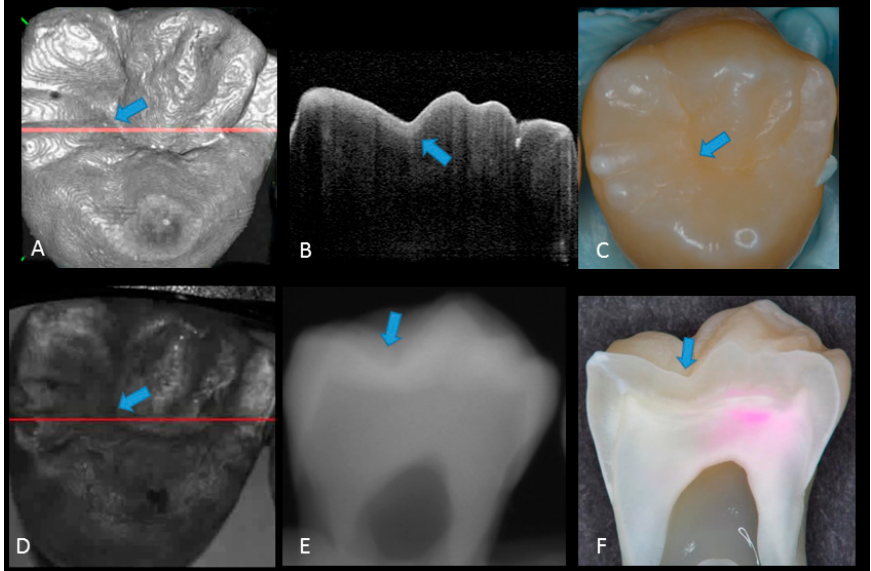
Figure 2. Sound enamel. ( A ) gray-scale three-dimensional (3D) OCT image; ( B ) cross-sectional OCT image along the red line in (A) and (D) with intact enamel with bright band across the fissure base extending over the cusps (arrow), suggesting a developmental feature (not acquired caries); ( C ) photographic presentation of occlusal enamel with seemingly intact fissure (arrow); ( D ) OCT en face intensity projection; ( E ) radiograph; ( F ) cross-sectional photograph with no dye at the observed fissure (arrow) confirming sound surface (score 0). The dynamic slicing 3D video is presented in Supplementary Materials: Video 1.